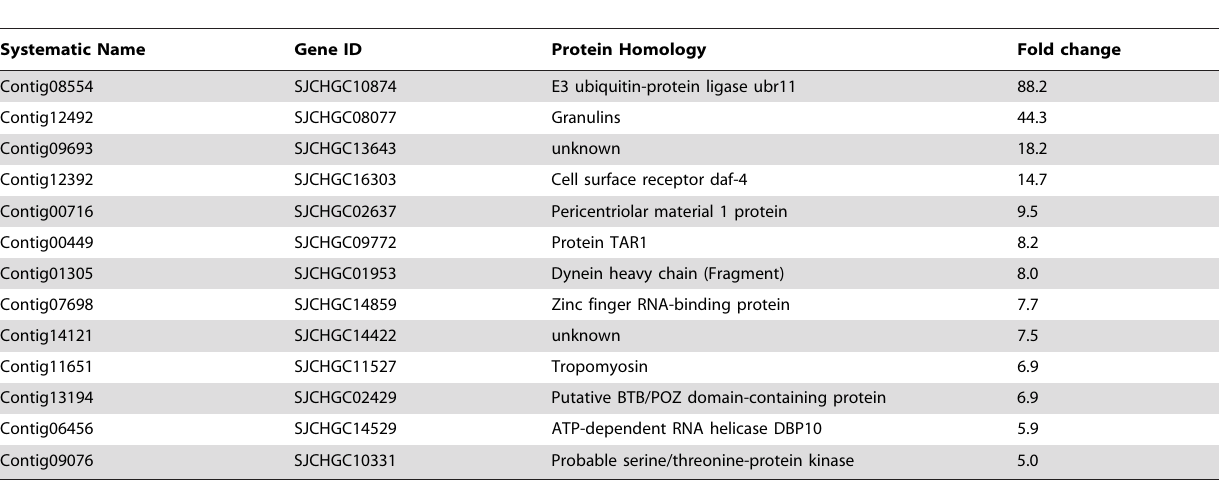
Table 1. Examples of up regulated expressed genes in schistosomula from Microtus fortis normalized with genes in those from BALB/c